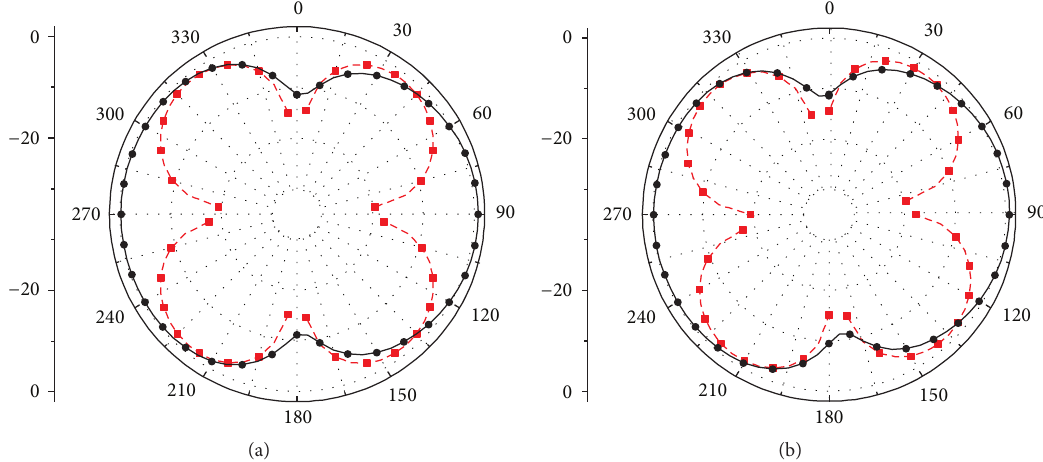
Figure 9: 2D radiation gain patterns of Notch 1 on (a) 𝑥 - 𝑧 plane and (b) 𝑦 - 𝑧 plane (the solid-line is the measured plots and the dot-line is the simulated plots).